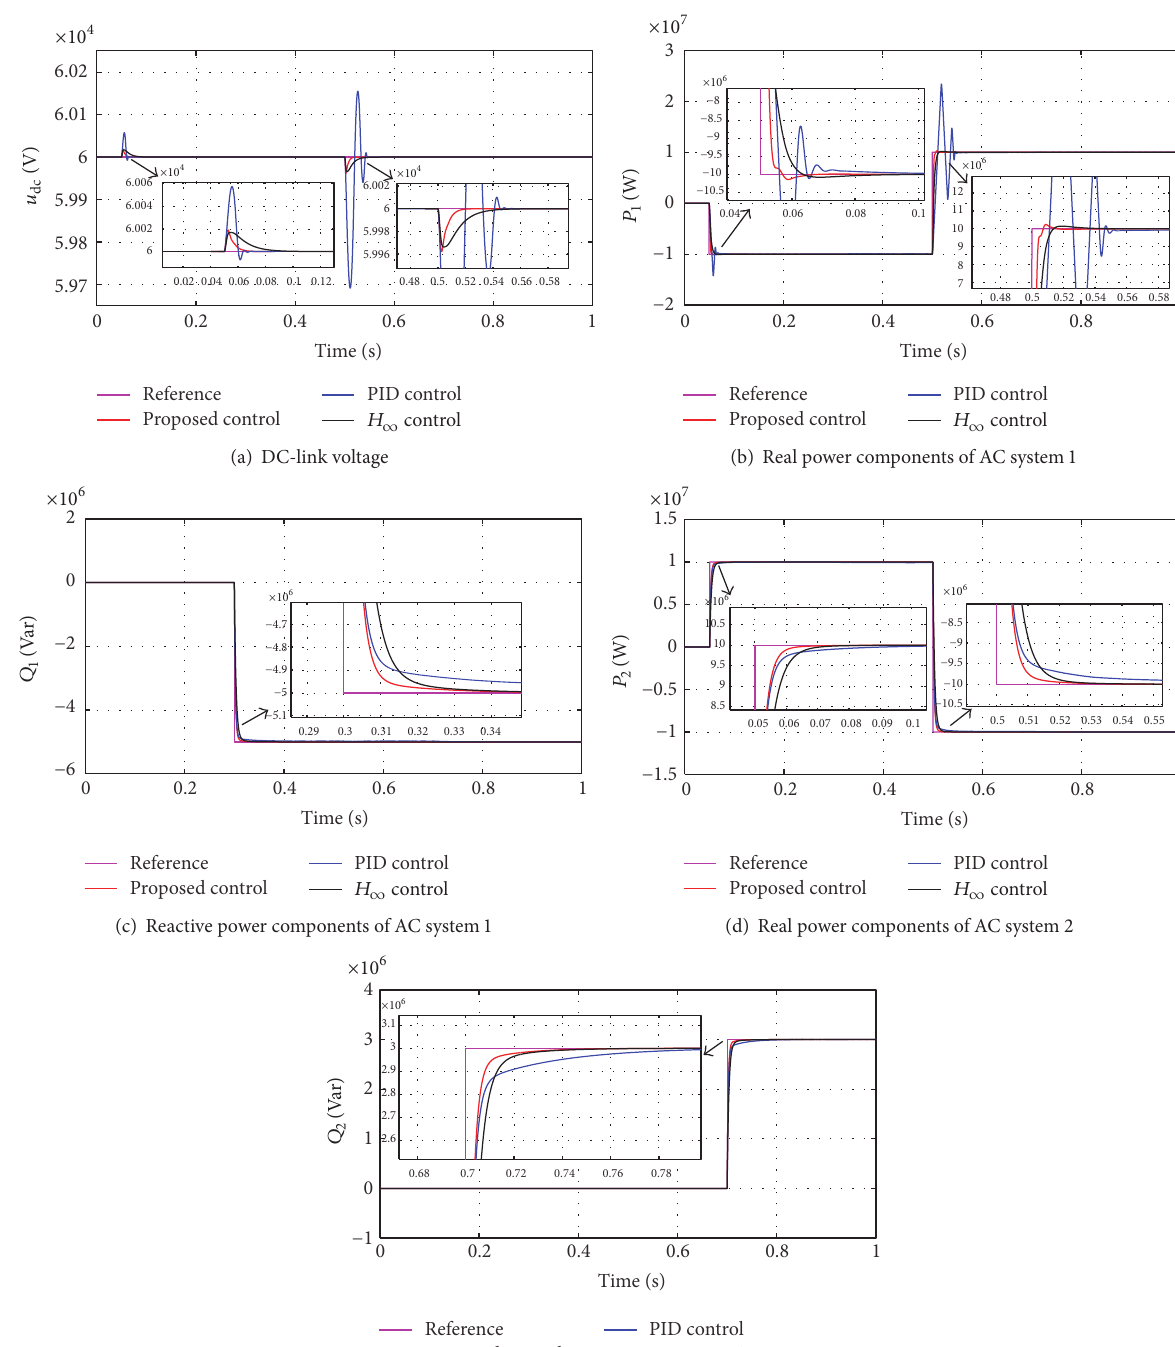
Figure 5: System response results of command-filtered backstepping control compared with PID control and 𝐻 ∞ controller.